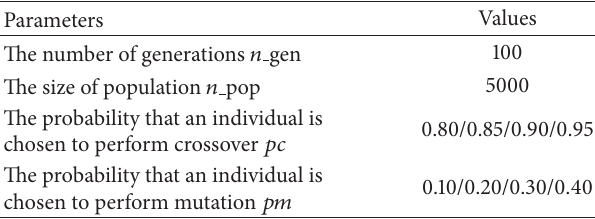
Table 2: The values of the main parameters in the